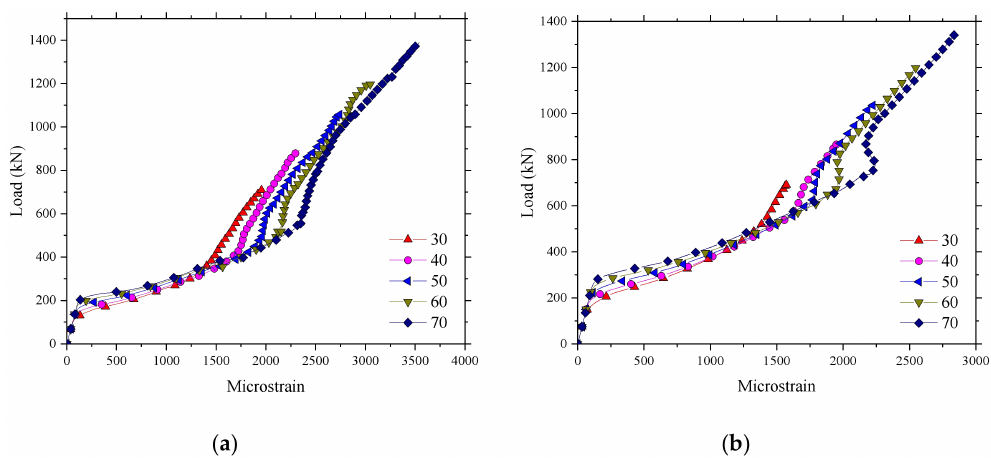
Figure 27. Influence of concrete compressive strength on the strain of the reinforcement. ( a ) Loading between the W-beams; ( b ) Loading between W-beams and